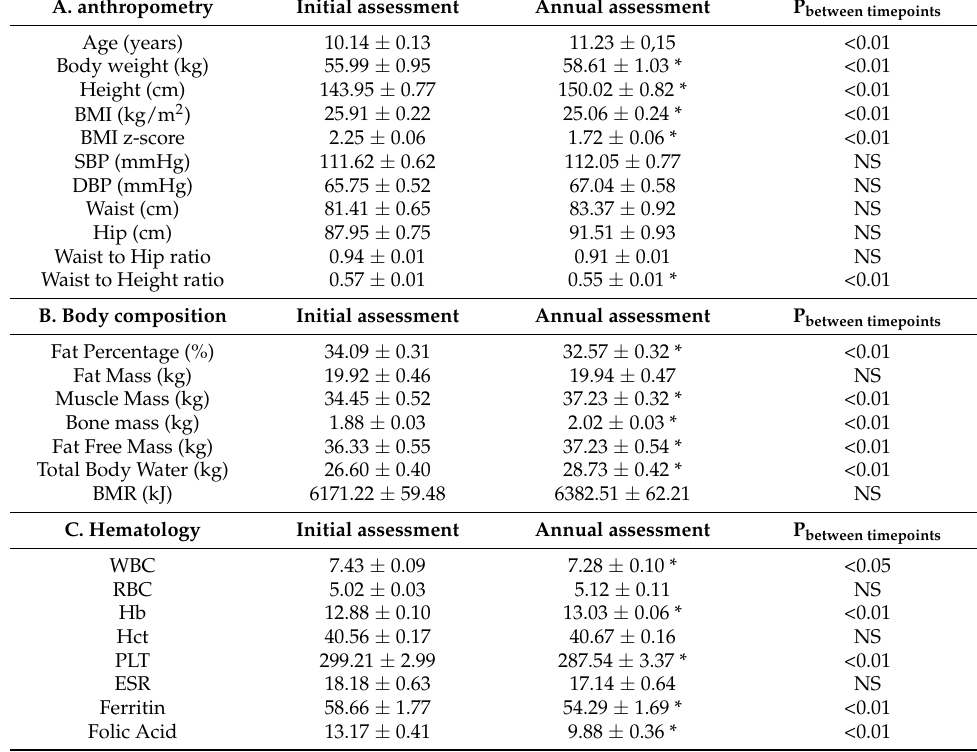
Table 2. Clinical characteristics and anthropometric parameters (2A), body composition parameters (2B), hematology (2C), biochemistry (2D), cardiometabolic (CVD) risk factors (2E), hormonal (2F) and leucocyte telomere length (LTL) (2G) measurements in all subjects with “good compliance” ( n = 407), at initial and annual